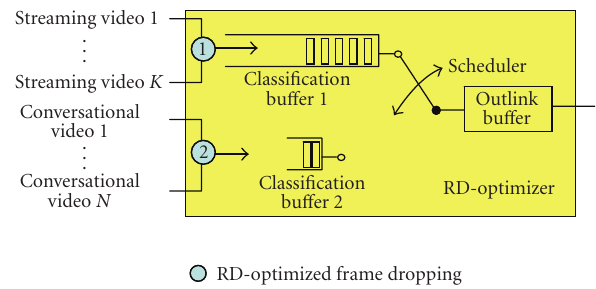
Figure 5: Structure of the RD-optimizer for frame dropping of streaming and conversational